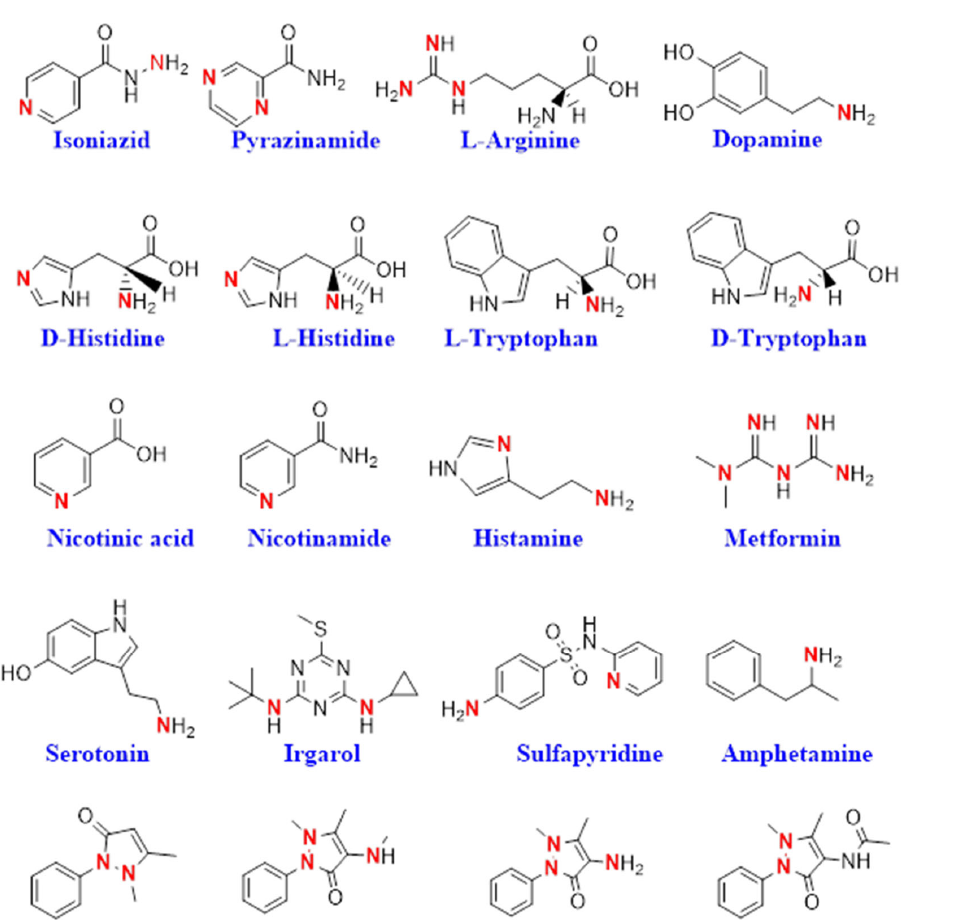
Figure 5. Chemical structures of bioactive compounds used to prepare [YH] x [3,3 ′‐ Co(1,2 ‐ C 2 B 9 H 11 ) 2 ] y . In red color were the amino groups that were expected to be basic enough to generate stable ion-pairs with [ o ‐ COSAN] − .